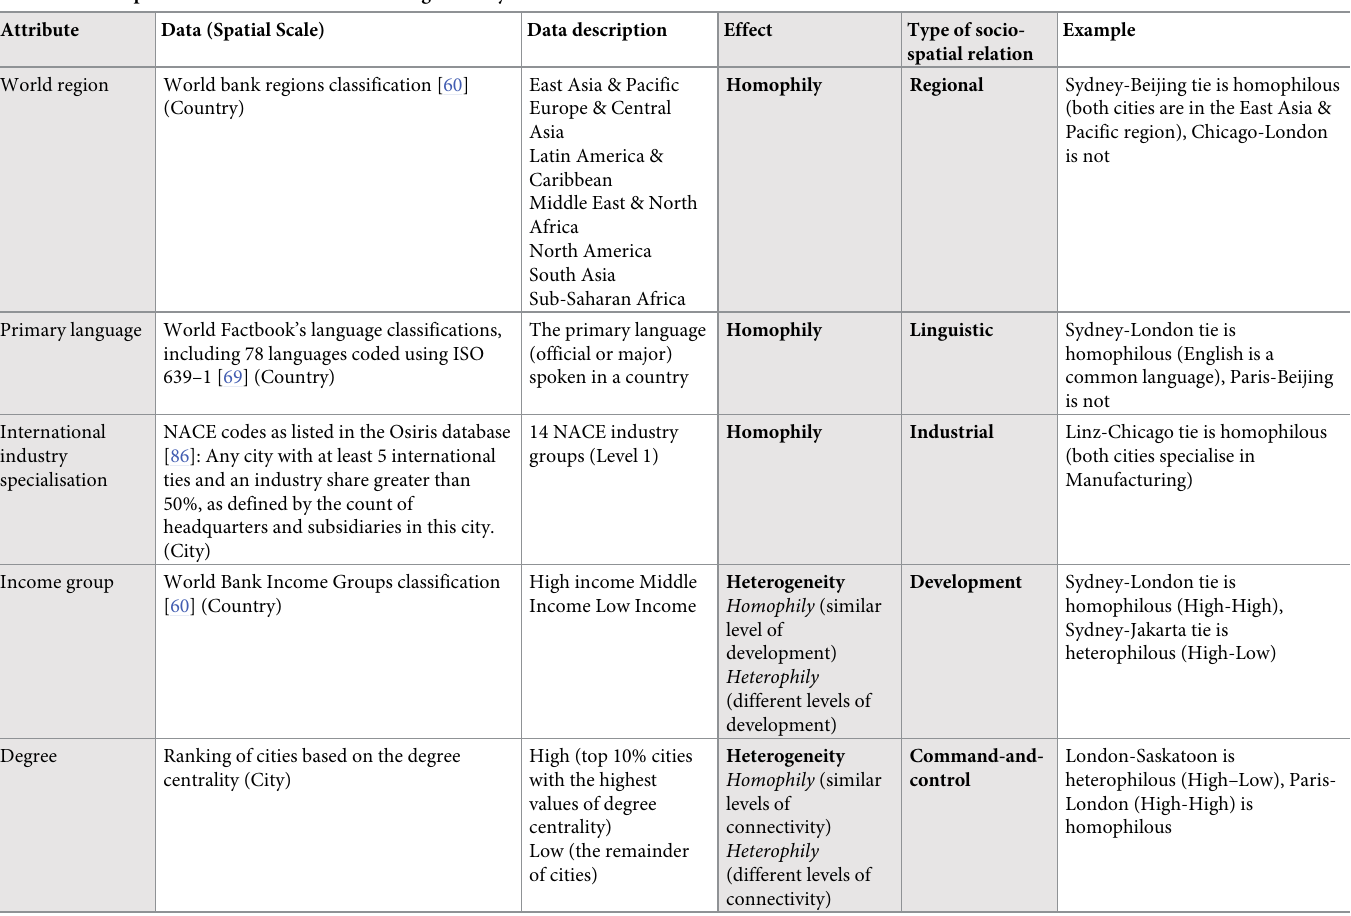
Table 1. Socio-spatial node-based attributes in the global city network of